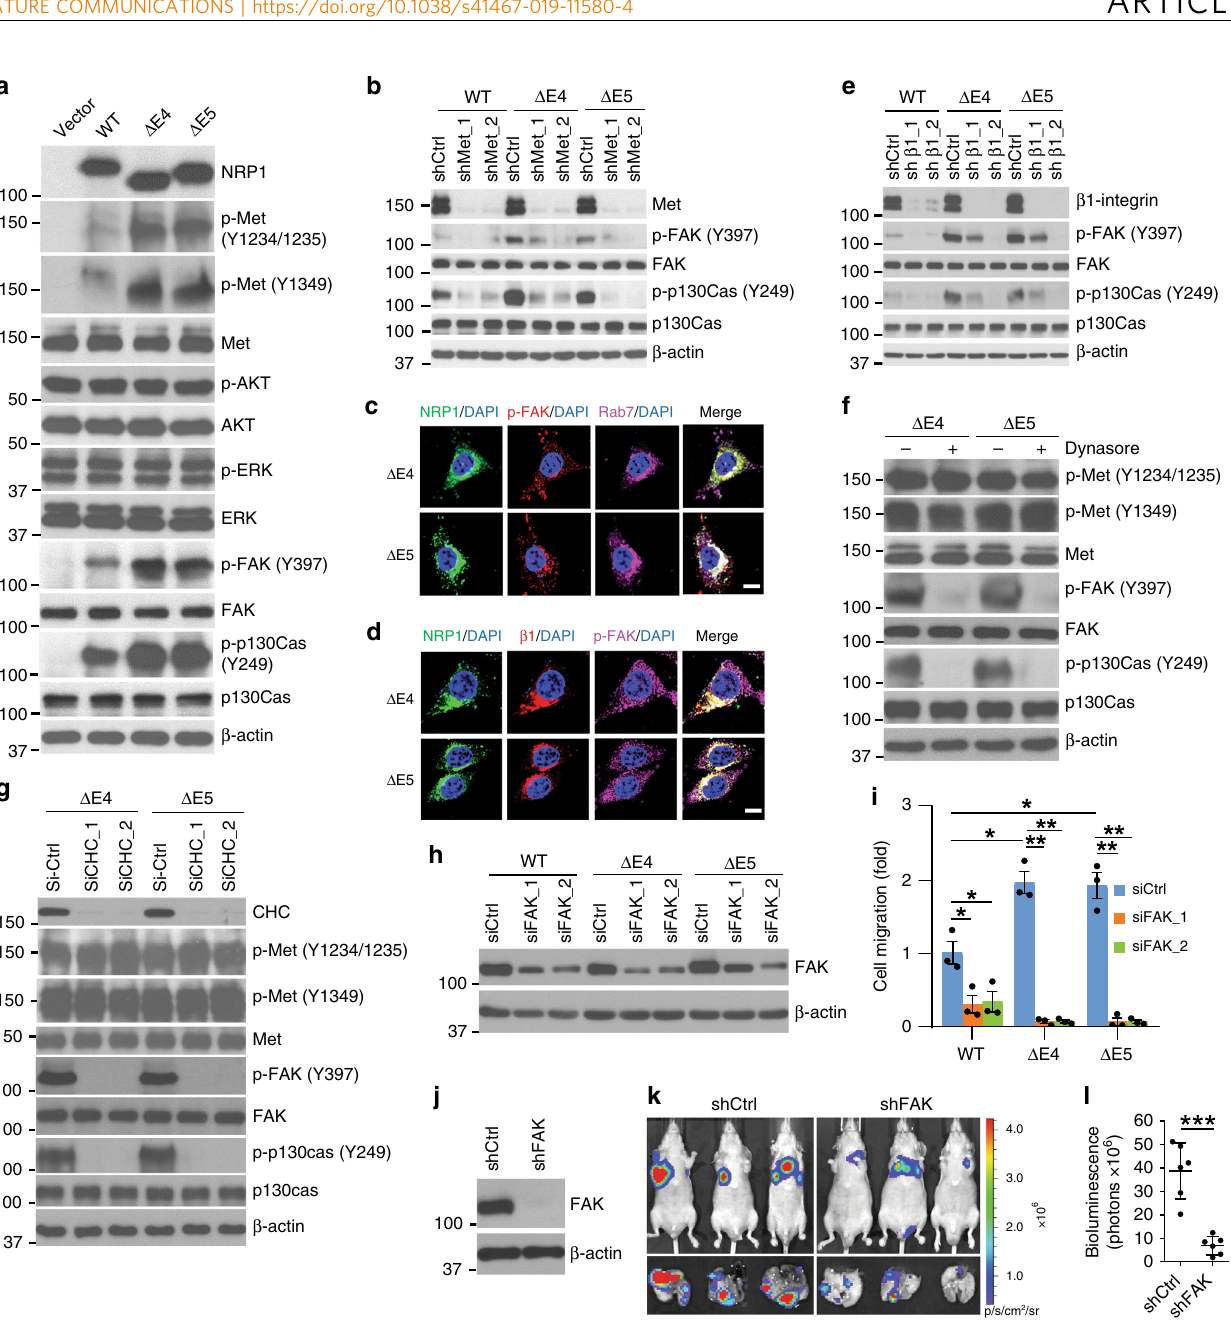
Fig. 8 The NRP1 variants activate the endosomal FAK signaling for CRC cell dissemination. a HCT116 cells with stable expression of vector control,